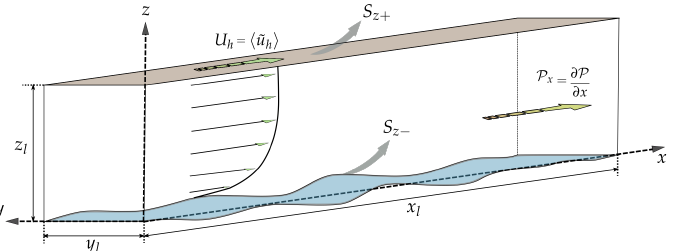
Figure 1. The wind tunnel-like simulation in Cartesian coordinates. Wind and waves are aligned to the x axis. The domain is bounded below by an arbitrary single-valued wave, and above by the freestream. The flow is driven by the large-scale pressure gradient ∂ P / ∂ x